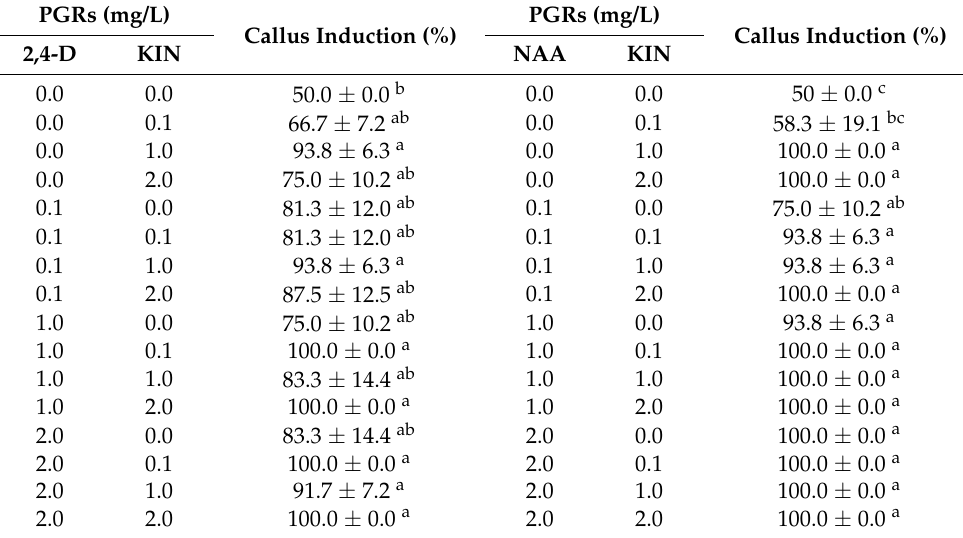
Table 1. Percentage of internodal explants of Eysenhardtia platycarpa inducing callus in Murashigue and Skoog (MS) culture medium after 30 days of culture.